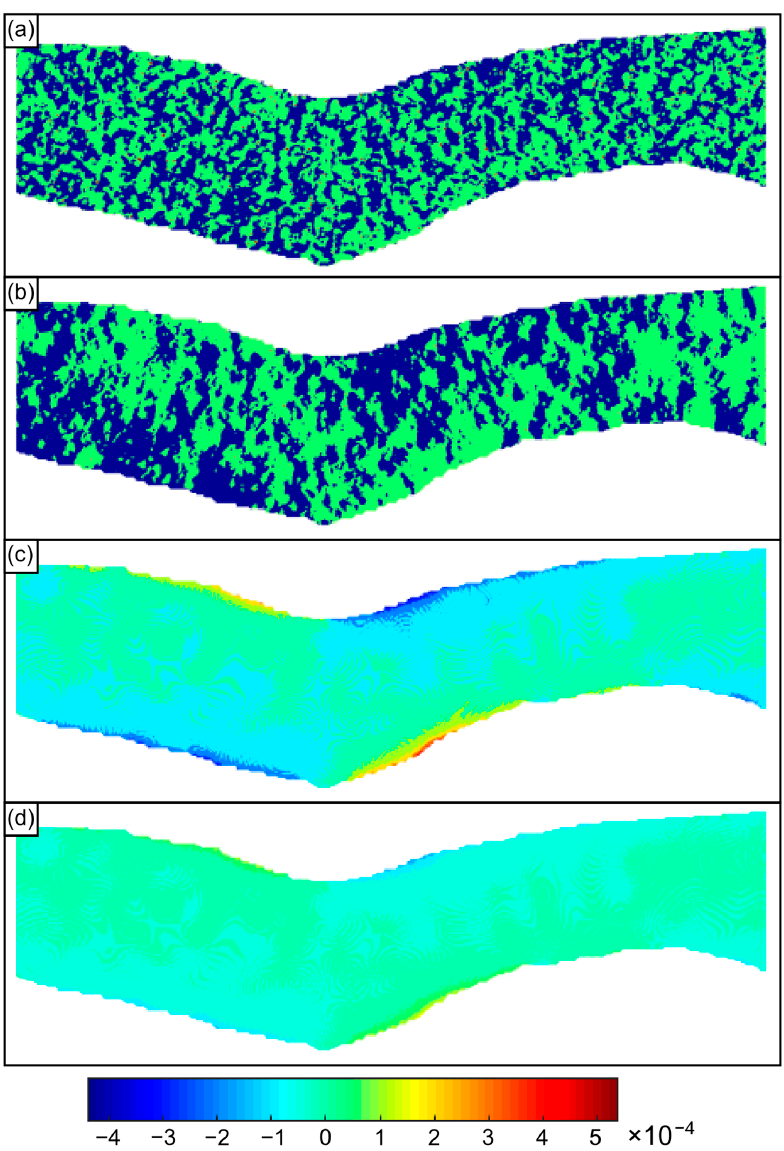
Figure 4. Interfacial flux (m s − 1 ) in the riverbed through ( a ) percolating and ( b ) non-percolating heterogeneous sediments, and ( c ) percolating and ( d ) non-percolating homogeneous sediments. Positive flux is into the riverbed; negative flux is out of the riverbed. Sorption strongly influences the breakthrough curves and the paths of solute migration. In both percolating and non-percolating heterogeneous sediments, an increase in the sorption coefficient of high -K facies altered the distribution of solutes throughout the riverbed, compressing the solute mixing zone and skewing the breakthrough behavior. When sorption was low within the high -K facies, the breakthrough behavior of sorptive solutes was comparable to that of conservative solutes; sorptive solute migration through the hyporheic zone was lower in non-percolating sediments. Sorption significantly impedes solute transport in homogeneous cases; the homogenous model corresponding to 10% high -K sediments with high sorption had the longest breakthrough curves. Breakthrough times were generally longer in non-percolating cases, and earlier breakthrough behavior was associated with percolating sediments. The sorptive behavior of high -K sediments